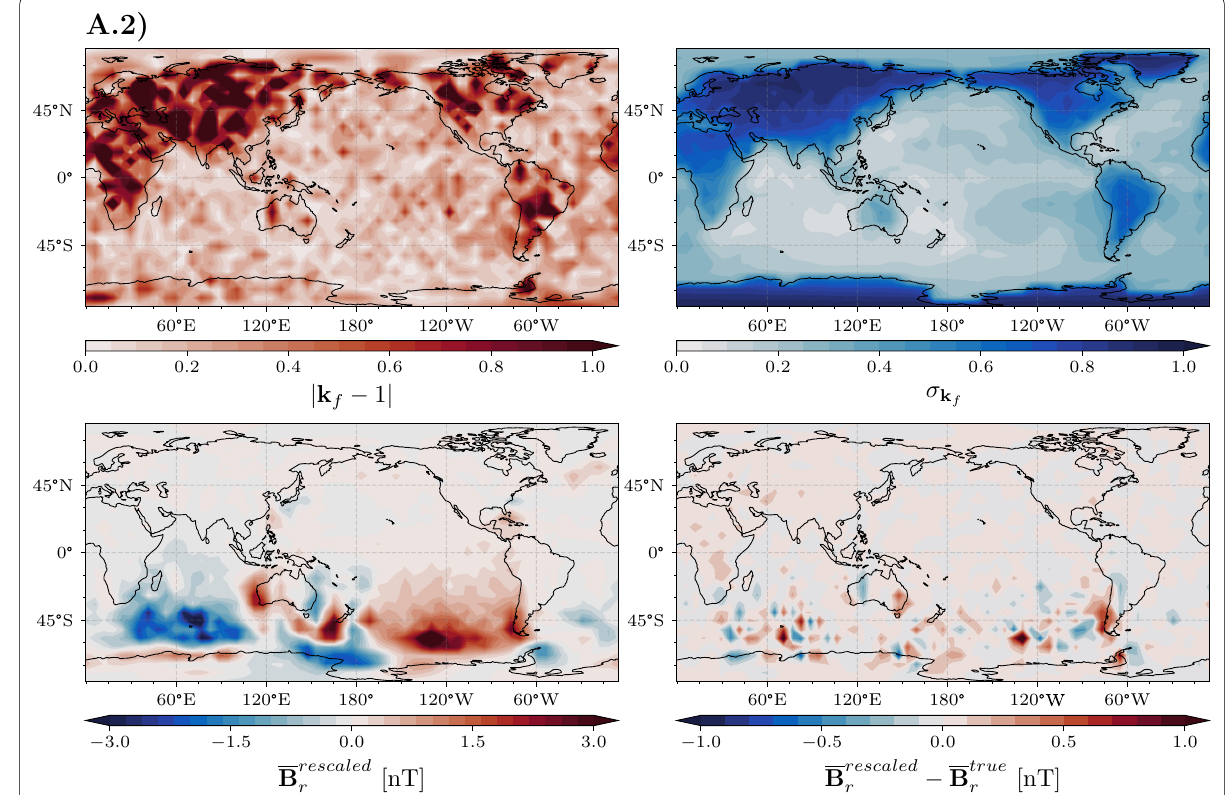
Fig. 6 The improved assimilation results using an additional prior spatial correlation in the case of identical true and imposed magnetic fields. Again, the upper plots show the absolute deviation of the final scale factor k f from the true value of 1 on the left and the associated uncertainty (posterior standard deviation) of the final scale factor σ k f on the right. The bottom plots present the corresponding temporal average of the radial rescaled rescaled OIMF B r on the left. And its deviation from the temporal averaged true radial OIMF